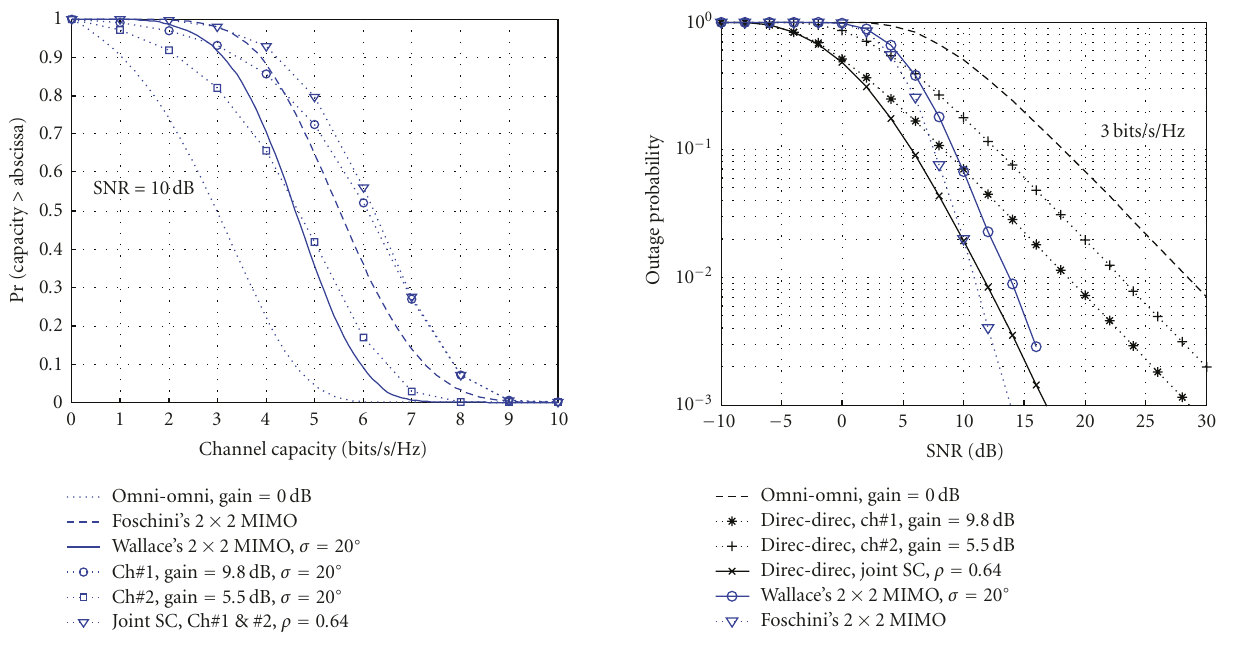
Figure 10: Shannon’s theoretical channel capacities of both BF and MIMO systems in di ff erent scenarios.